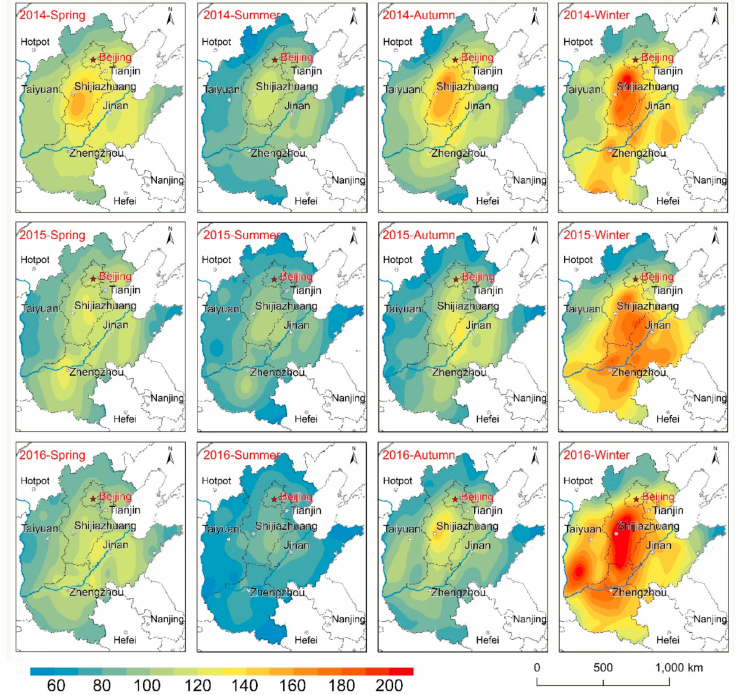
Figure 6. Seasonal spatial distribution matrix of AQI in North China